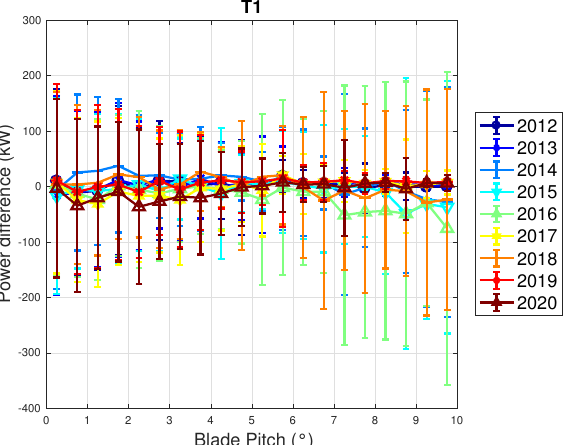
Figure 6. A sample binned blade pitch–power curve in Region 2 1 / 2 for WF1: the curves are reported in the form of difference with respect to the year 2011.